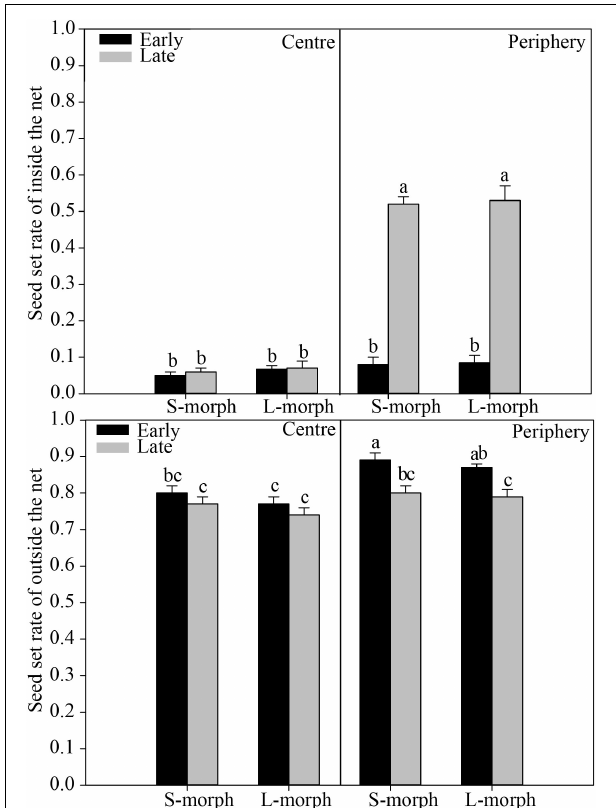
FIGURE 6 | Seed set rate of the central and peripheral populations of P. wannanensis under different experimental treatments. Error bars indicate mean ± standard error (SE), and superscript lowercase letters indicate significant differences ( P <